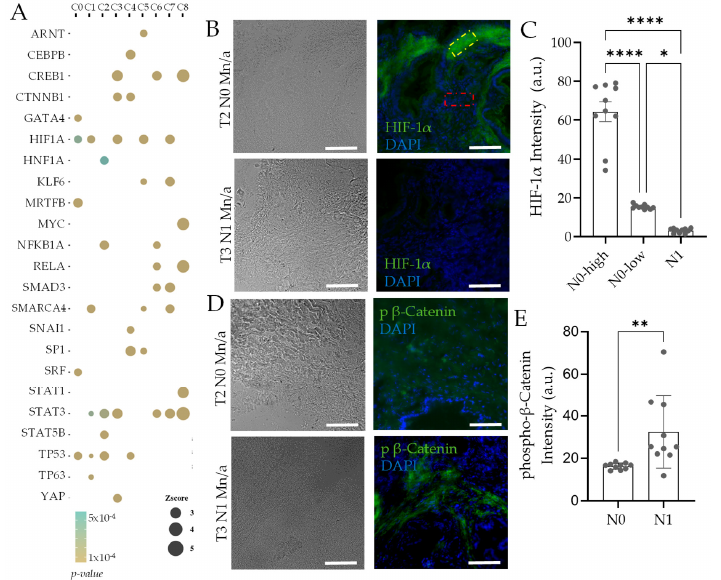
Figure 2. Predicted stage-wise activation of transcription factors in fibroblasts is indicated in patient samples of PDAC cancers. ( A ) Top 5 IPA-predicted transcription factors activators in each fibroblast cluster identified in Figure 1 and their z-score in all other clusters. ( B – E ) Immunohistochemistry in patient tumor samples before and after lymph node metastasis (termed N0 and N1, respectively, in TNM nomenclature) for predicted TFs exclusive to C5 and C4 clusters present in respective stages. ( B ) Representative phase and immunofluorescence images showing areas with very high (green square) and moderate fluorescence intensity (red square) in areas stained with HIF-1 α antibody in the non-metastasized sample (T2N0), while reduced HIF-1 α levels in the patient samples with lymph metastasis (T3N1); Quantification of HIF-1 α levels in N1 and N0 samples in spatial categories indicated in ( C ). ( D ) Representative phase and immunofluorescence images show that stromal areas in patient samples with a tumor that has disseminated to a lymph node (T3N1) show areas with high levels of phosphorylated β -catenin, not present in tumors without stromal invasion to lymph node (T2N0) as predicted in A; Quantification shown in ( E ). For C, E; n = 10 locations, from 3 sections of the indicated patient samples; Scale bar = 100 µm. Error bars: s.e.m.; p-values: *: p < 0.05, **: p < 0.01; ****: p < 0.0001.